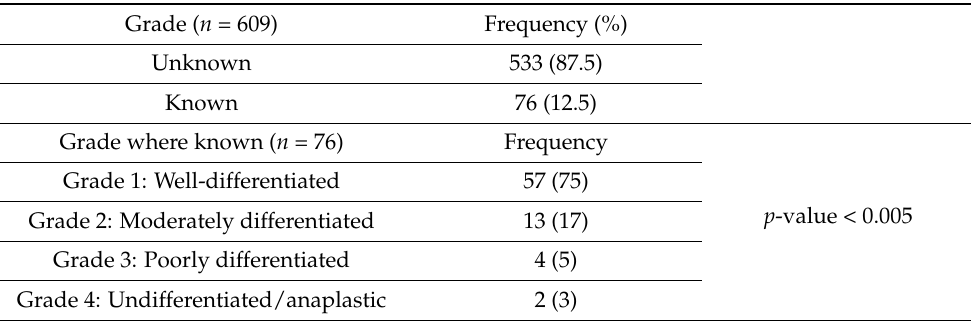
Table 4. Histological grades of 609 patients with parathyroid cancer from the Surveillance, Epidemi- ology, and End Results (SEER) database, 1975–2016.